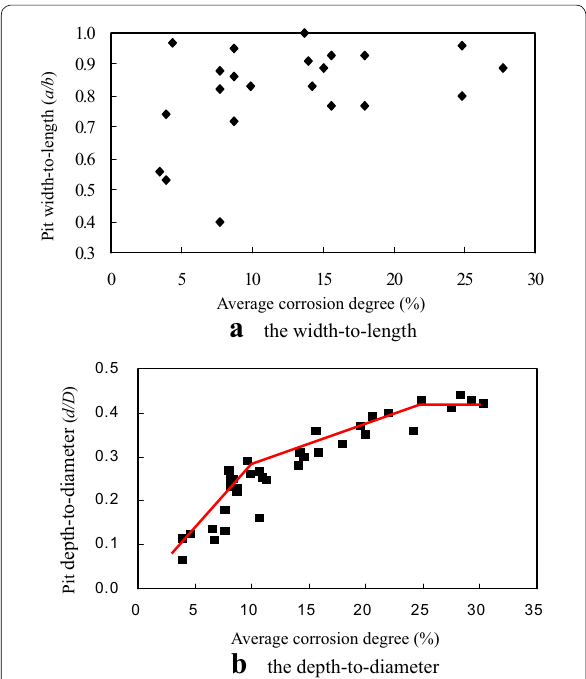
Fig. 3 The relations between geometry parameters and the average mass